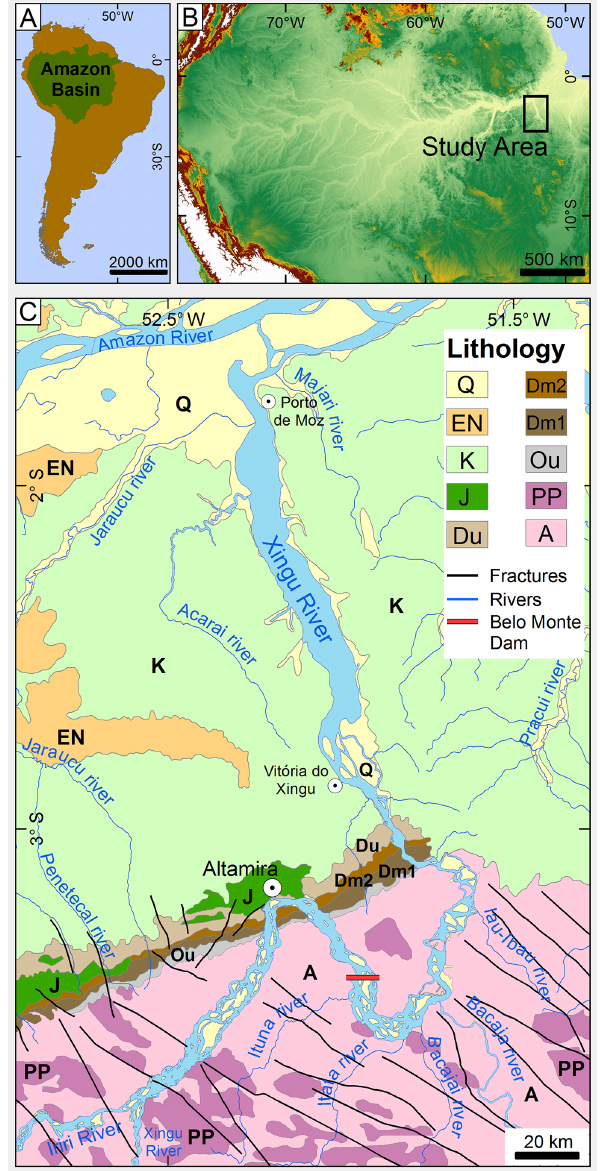
Figure 1. Simplified geological map of the Volta Grande do Xingu and Xingu ria, eastern Amazonia (Bahia et al., 2004). Litholo- gies: (A) Archean gneisses, granodiorites and granitoids (Xingu complex) and metavolcanic and metasedimentary rocks; (PP) intru- sive suites: Paleoproterozoic granites, granodiorites and charnock- ites; (Ou) Ordovician–Devonian organic-rich shales and sand- stones (Trombetas group); (Dm1–Dm2–Du) Middle–Upper Devo- nian shales, siltstones and sandstones (Urupadi and Curuá groups); (J) Triassic–Jurassic diabase (Penatecaua formation); (K) Alter do Chão formation: sandstones and conglomerates; (EN) Eocene– Neogene undifferentiated sediments and laterite crusts; (Q) undif- ferentiated Quaternary sediments. The red bar indicates the position of the main Belo Monte dam (Pimental site).